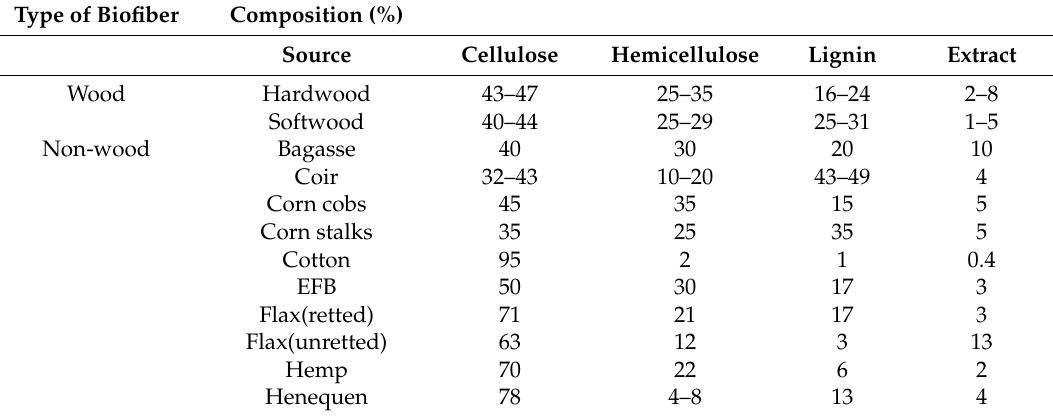
Table 1. Chemical composition of cellulose containing materials (Adapted from